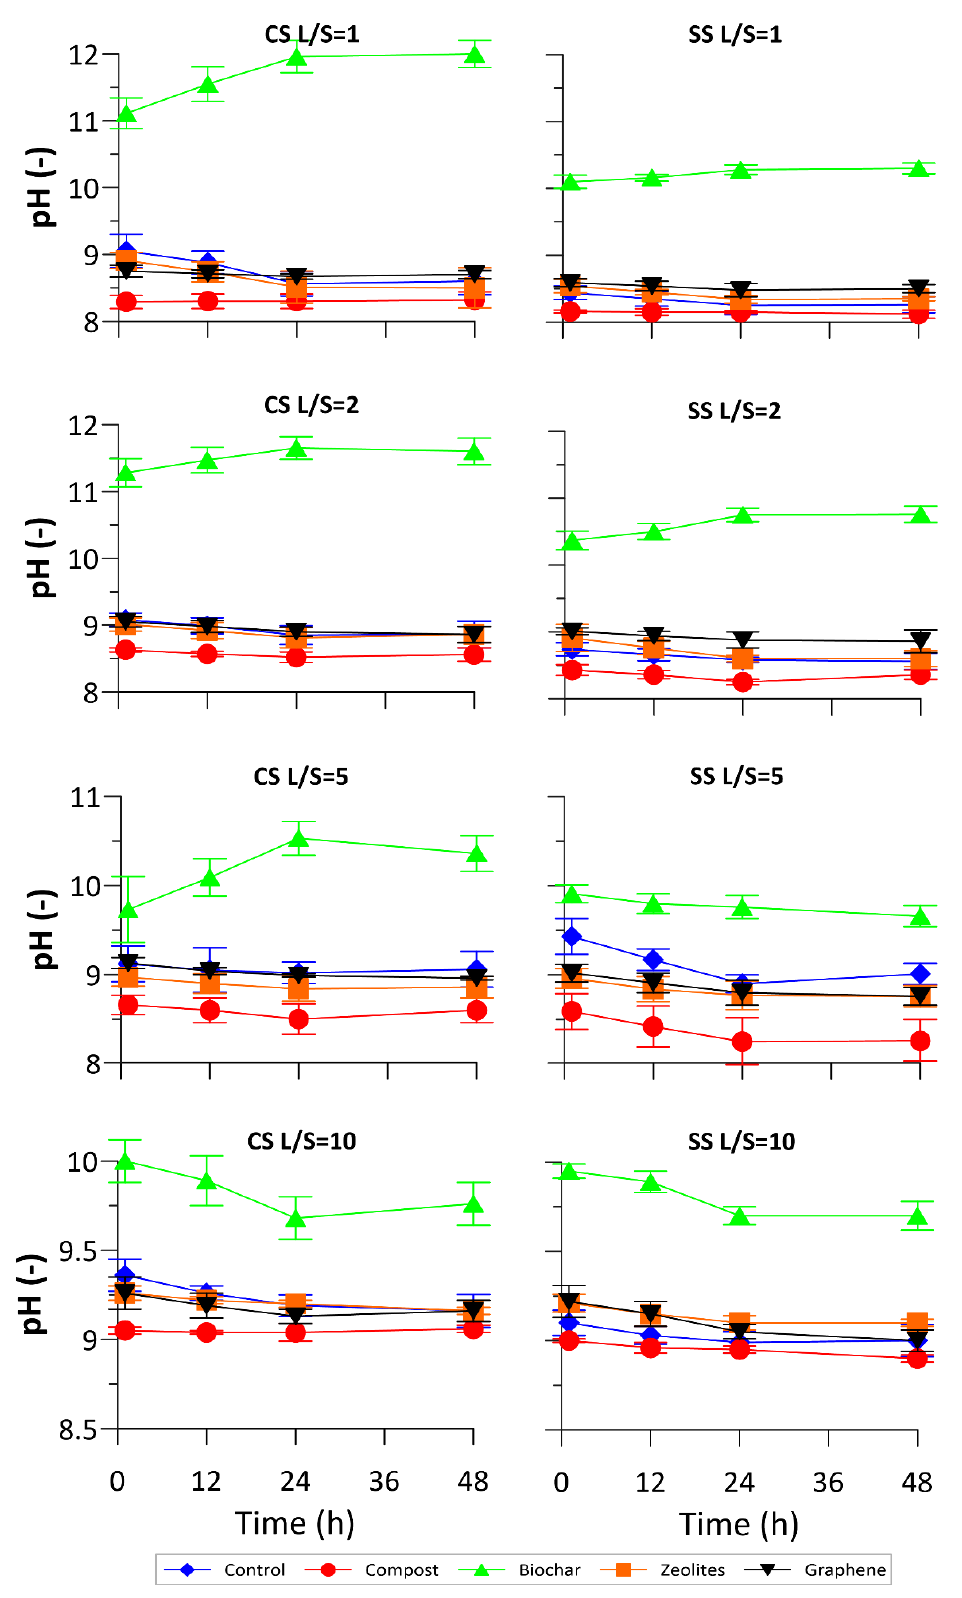
Figure 3. pH values variation in SSE batches experiments with CS ( left panels ) and SS ( right panels ) for different L/S ratios. Error bars denoted standard deviation calculated on three replicas. Different letters indicate statistically different means at 0.05 confidence.